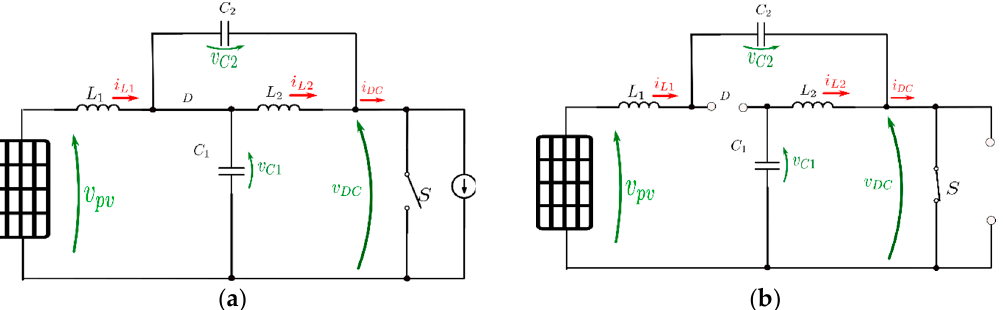
Figure 4. A single-phase qZSI.